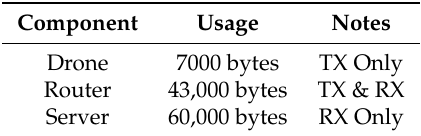
Table 6. Bandwidth usage for Configuration 3.